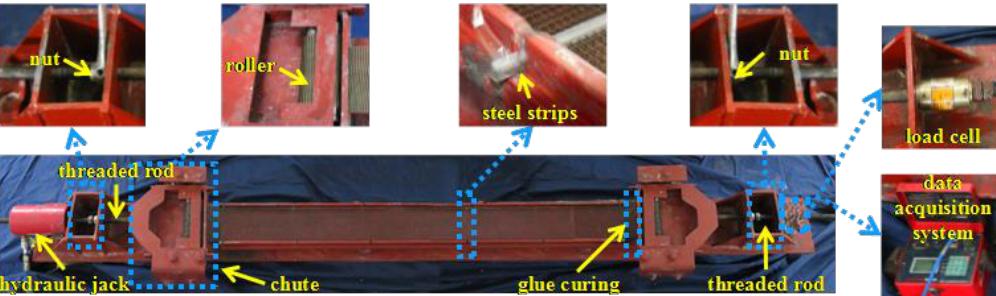
Figure 4. Illustration of prestress tensioning device. Polymers 2018 , 10 , 98